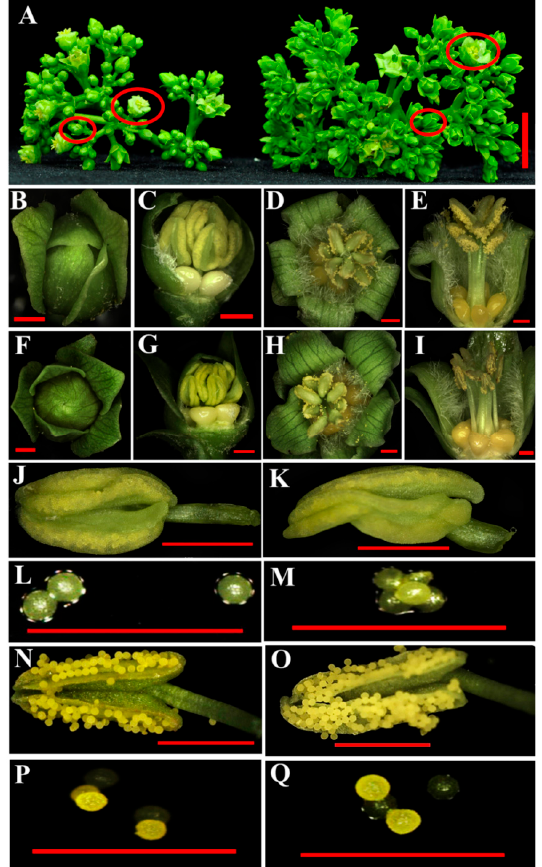
Figure 8. Morphology of the anthers and pollen grains in the JcDAD1 -RNAi transgenic and wild type (WT) plants. ( A ) Inflorescences of the WT (left) and transgenic line L2 (right). Small circles shown in ( A ) represent the flowers shown in ( B , F ); and large circles shown in ( A ) represent the flowers shown in ( D , H ). ( B ), ( C ), ( F ) and ( G ) Unopened flowers. ( D ), ( E ), ( H ) and ( I ) Opened flowers. ( C ), ( E ), ( G ) and ( I ) Anatomy of the flowers shown in ( B ), ( D ), ( F ) and ( H ), respectively. ( B − E ) Male flowers from the WT plants. ( F − I ) Male flowers from the transgenic L2 plants. ( J , K ) Indehiscent anthers. ( N ) and ( O ) Dehiscent anthers. ( L , M ) Pollen grains from the anthers shown in ( J , K ), respectively. ( N , O ) Pollen grains from the anthers shown in ( P , Q ), respectively. ( J ), ( L ), ( N ) and ( P ) Male flowers of the WT plants. ( K ), ( M ), ( O ), and ( Q ) Male flowers of the transgenic L2 Jatropha plants. Bar = 2.0 cm shown in ( A ); bars = 1.0 mm shown in ( B − K ), ( N , O ); bars = 500.0 μ m shown in ( L ), ( M ), ( P ) and ( Q ).